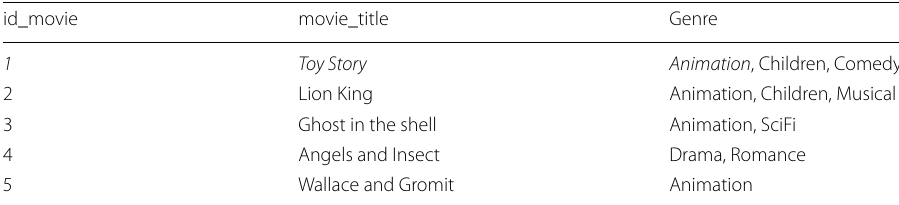
Table 1 Examples of movie